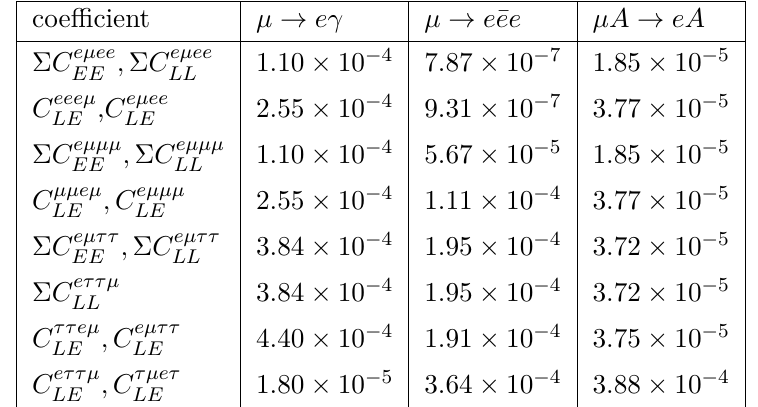
Table 6 . Current sensitivities of the processes in the first row to the coefficients of SMEFT operators at m W , added to the Lagrangian as in eq. (A.1). P C ζ eq.